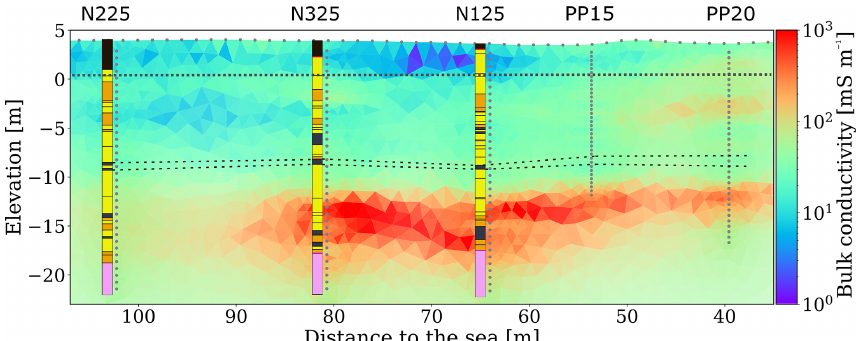
Figure 4. Result from the inversion of surface and cross-hole ERT (dataset from 8 September 2015). Stratigraphic columns are shown to relate stratigraphic units with bulk conductivities. Gray dots represent the electrodes around the boreholes and on surface. The gray dashed line indicates the approximate groundwater table. The black dashed line indicates the silt layer. This cross section is used as reference model in the time-lapse